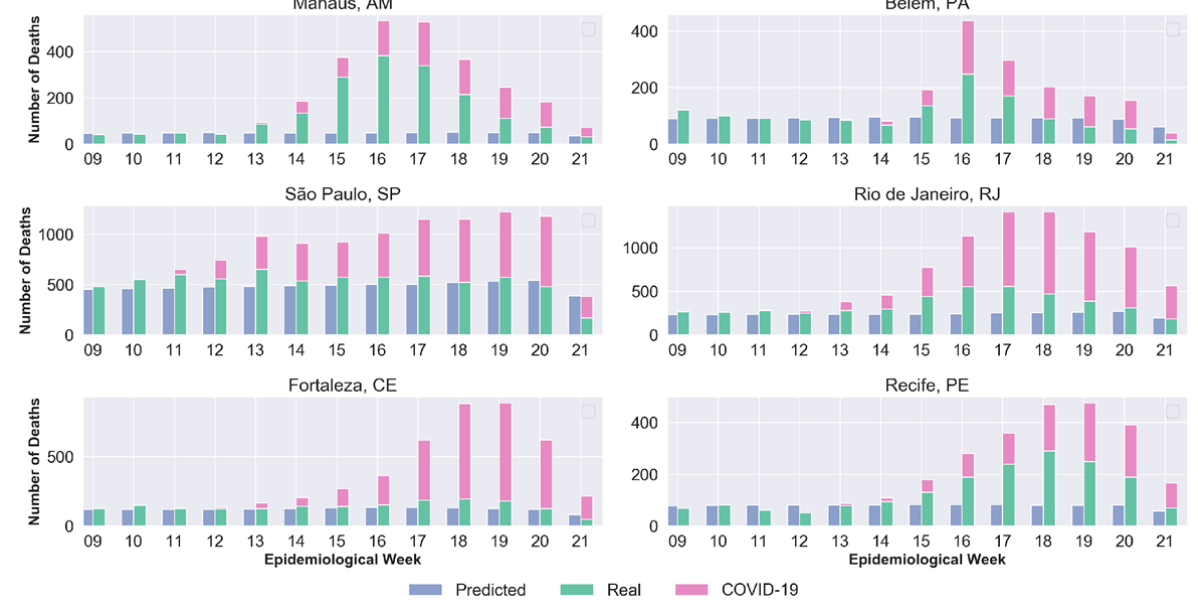
Figure 3. Predicted and actual deaths per epidemiological week related to respiratory diseases. COVID-19: coronavirus disease.